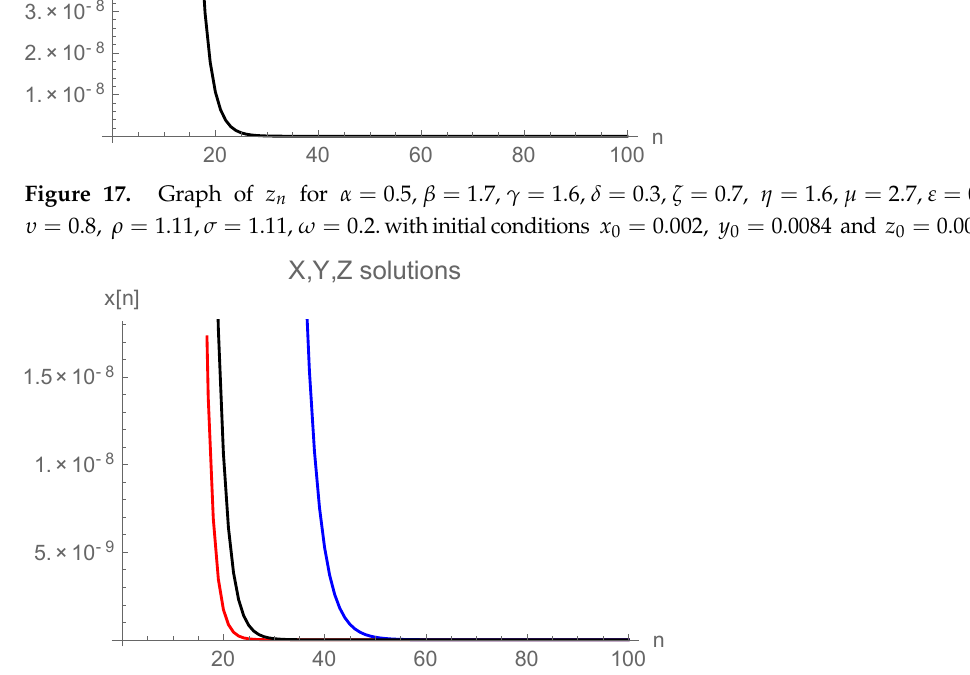
Figure 18. Combined graph of solution behavior of x n is shown in red line, and for y n is shown in blue line, for z n is shown in black line when α = 0.5, β = 1.7, γ = 1.6, δ = 0.3, ζ = 0.7, η = 1.6, µ = 2.7, ε = 0.6, υ = 0.8, ρ = 1.11, σ = 1.11, ω = 0.2. with initial conditions x 0 = 0.002, y 0 = 0.0084 and z 0 =